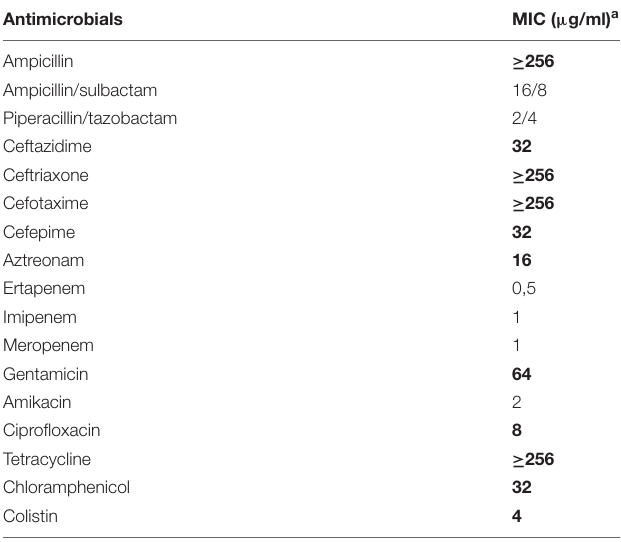
TABLE 1 | MICs of antimicrobials for mcr-1 -positive ESBL-producing E. coli strain S802 from agricultural soil.